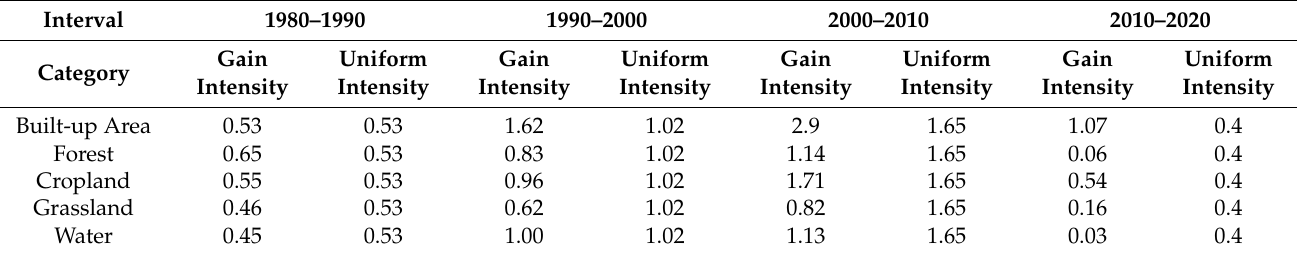
Table 18. Category-level Gain